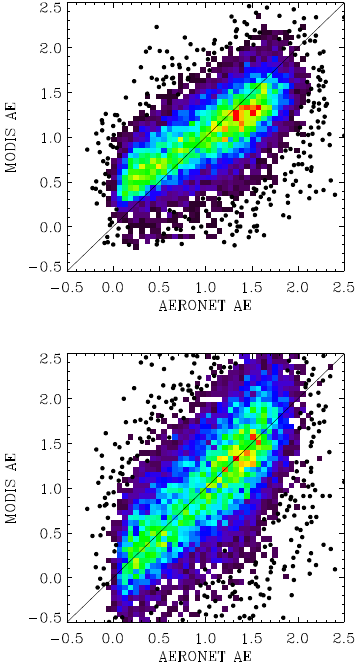
Fig. 13. Density plots of MODIS Aqua AE vs. AERONET AE for the original (top panel) and corrected (bottom panel)